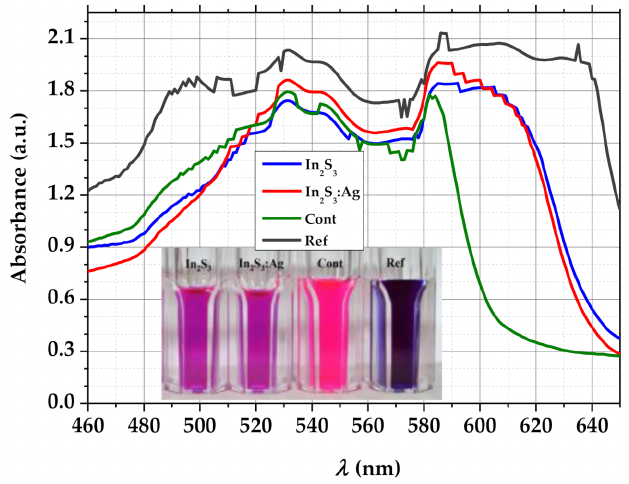
Figure 9. Variation of Pseudomonas aeruginosa solution absorption as a function of wavelength and cell viability test with and without In 2 S 3 :Ag and In 2 S 3 thin films: In 2 S 3 :Ag and In 2 S 3 identify the solutions with the immersed samples, Cont. and Ref. are the control and reference solutions. The Ref. solution does not contain